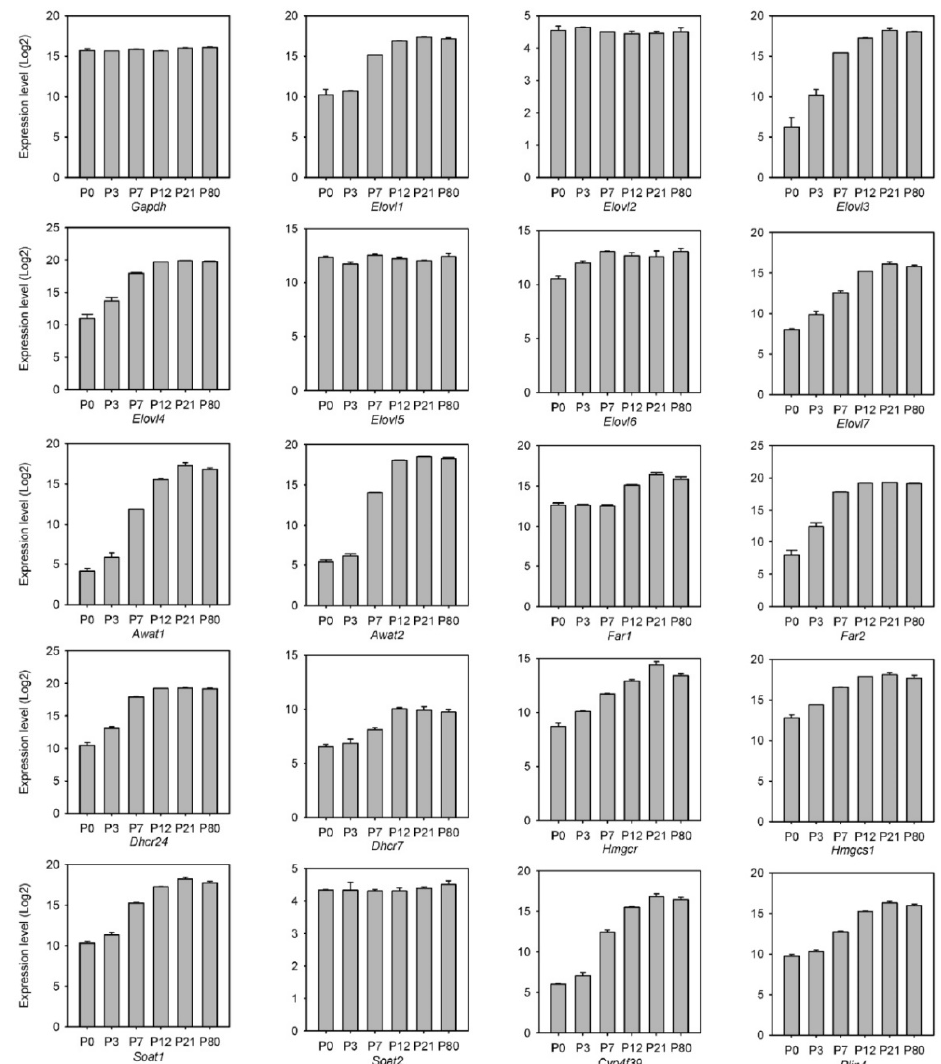
Figure 9. Dynamic changes in the expression levels of selected major genes of meibogenesis in P0 (newborn) pups to P80 (adult) mice measured using mRNA microarrays.